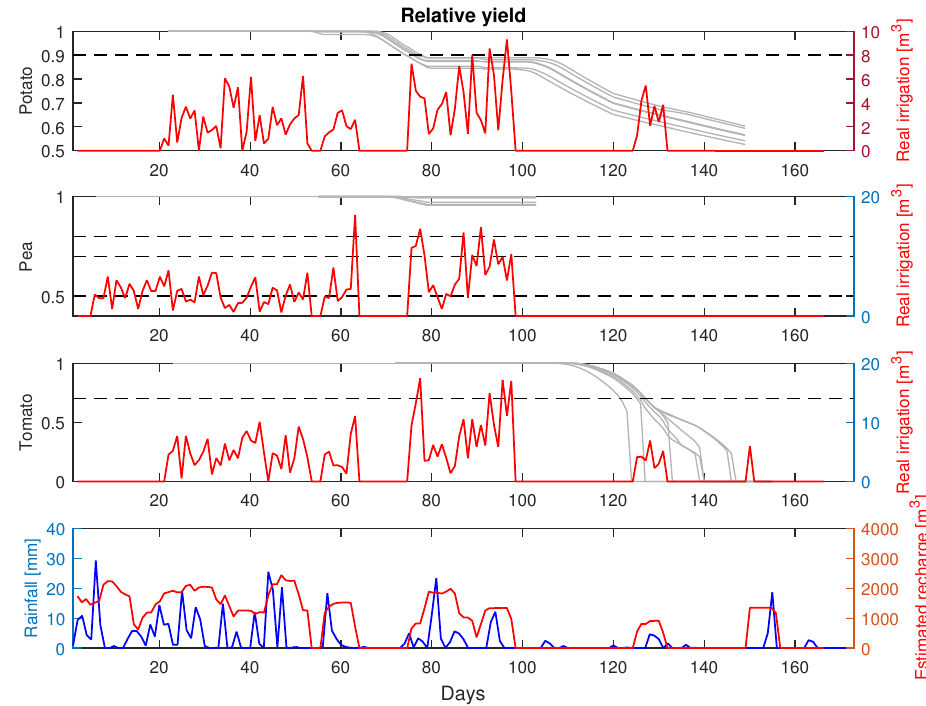
Figure 9. EWMS for crop yields, irrigation, rainfall, and estimated recharge for scenario 2 ( S 2 ). The left y-axis in the potato, pea, and tomato plots indicates the relative yield of the different crops (gray) and their expected relative yields (dashed line), and the right y-axis indicates the irrigation (red). The fourth plot shows the measured rainfall (blue) and the estimated recharge